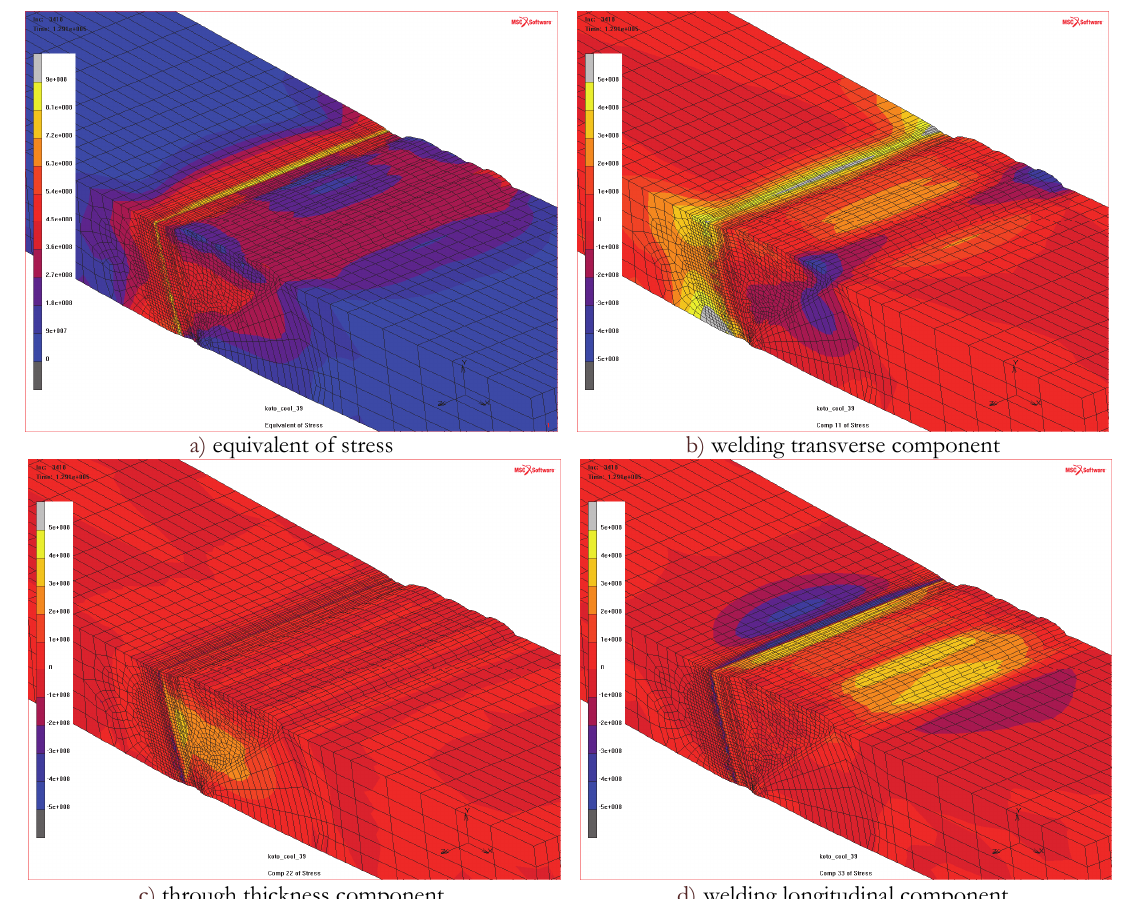
Figure 10: Predicted residual stress distributions [Pa] after